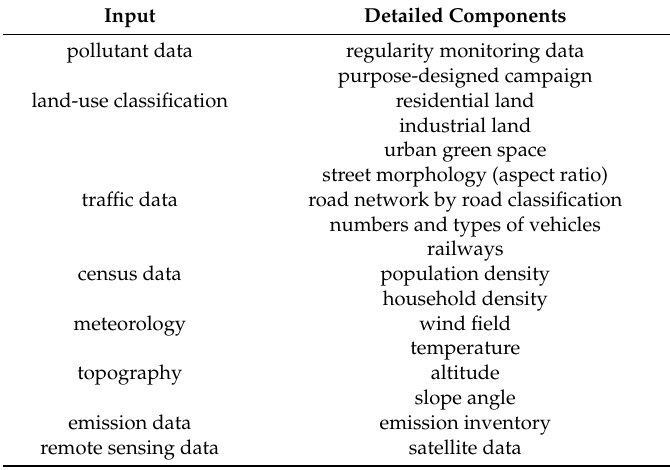
Table 2. Summary of example input data for the application of a land-use regression (LUR)